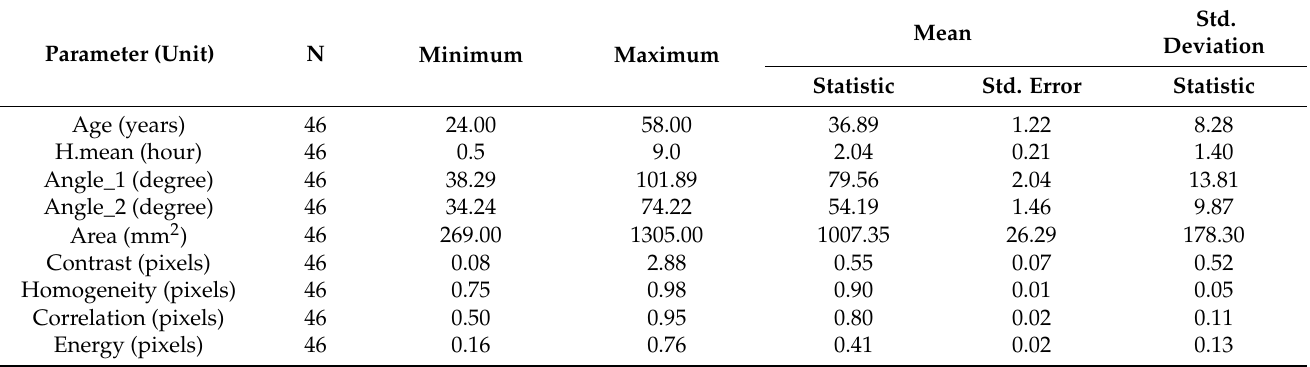
Table 4. Statistics of the descriptive variables (i.e., age, H.mean, angle_1, angle_2, area, contrast, homogeneity, correlation, and energy) used in this